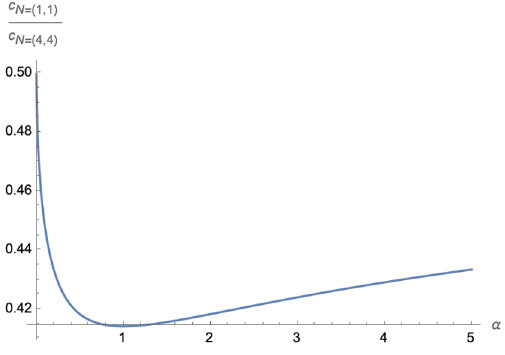
Figure 2. Ration of central charges for the N = (1 , 1) and N = (4 , 4)